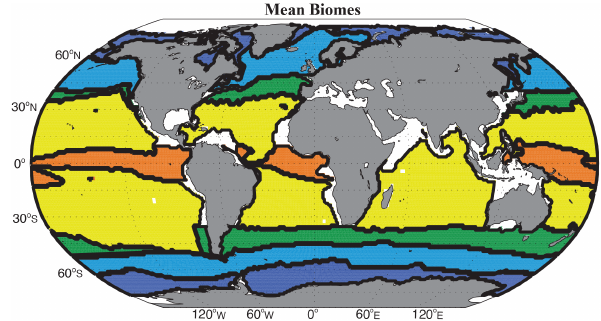
Figure 1. Mean biome map created from mean climatologies of maxMLD, SST, summer Chl a , and maximum ice fraction. Dark blue: ice biome (ICE); cyan: subpolar seasonally stratified biome (SPSS); green: subtropical seasonally stratified biome (STSS); yellow: subtropical permanently stratified biome (STPS); orange: equatorial biome (EQU). White indicates ocean areas that do not fit the criteria for any biome and are excluded from further